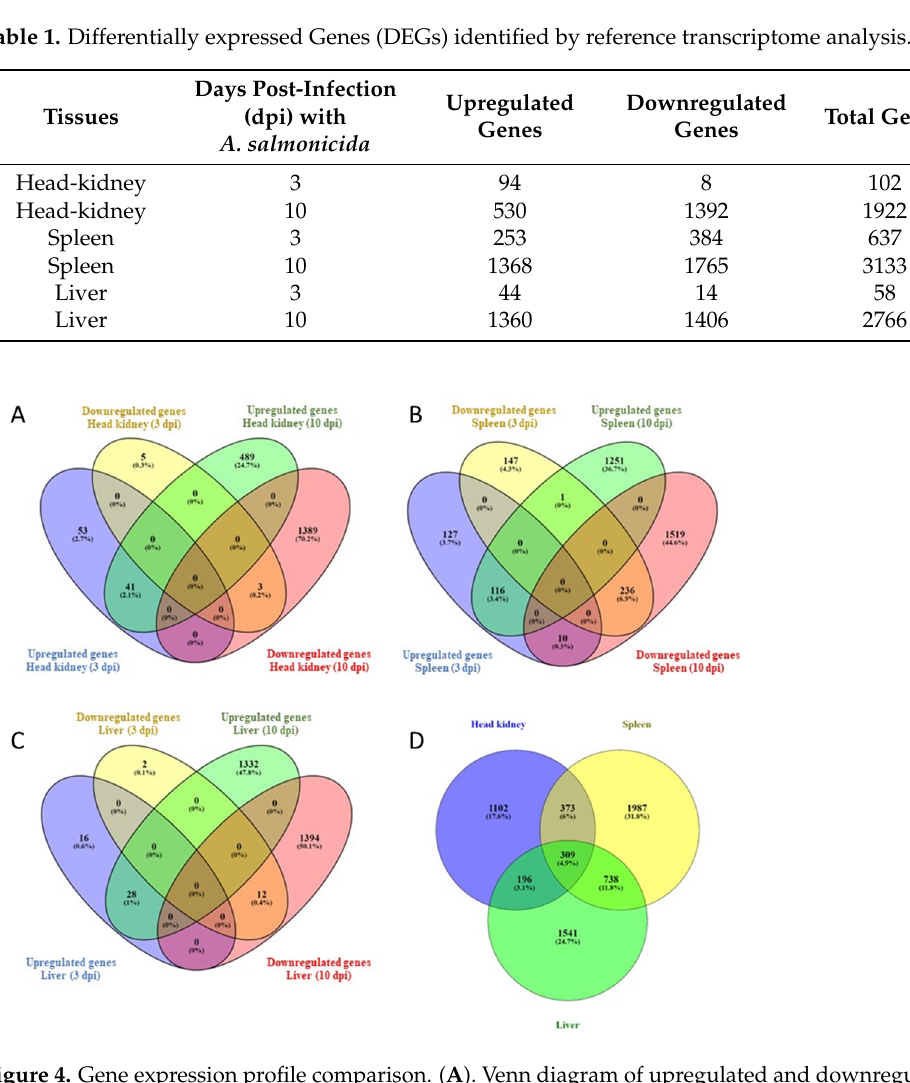
Figure 4. Gene expression profile comparison. ( A ). Venn diagram of upregulated and downregulated DEGs (log 2 FC ≥ 1, FDR ≤ 0.05) in head-kidney at 3 and 10 dpi; ( B ). Venn diagram of upregulated and downregulated DEGs (log 2 FC ≥ 1, FDR ≤ 0.05) in spleen at 3 and 10 dpi; ( C ). Venn diagram of upregulated and downregulated DEGs (log 2 FC ≥ 1, FDR ≤ 0.05) in the liver at 3 and 10 dpi; ( D ). Venn diagram of all DEGs (log 2 FC ≥ 1, FDR ≤ 0.05) in head-kidney, spleen, and liver.